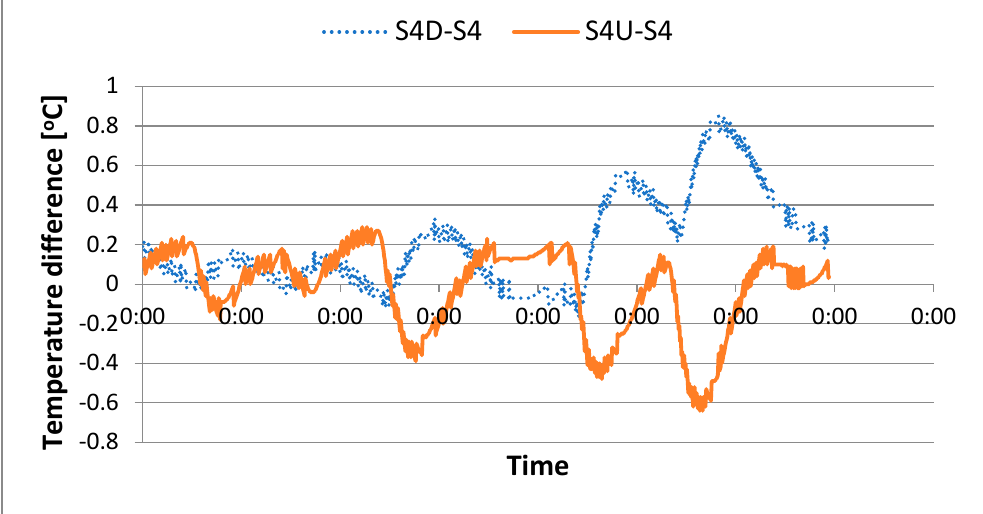
Figure 8. Temperature differences S4D-S4 and S4U-S4 indicating vertical heat flow in wall on 21–27 June